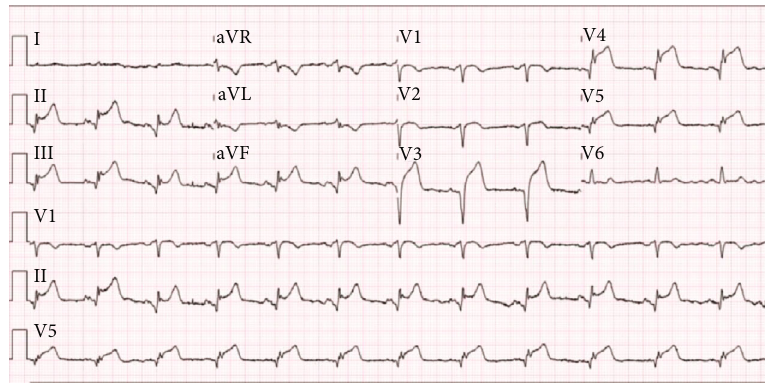
Figure 4: Electrocardiogram exhibiting ST-segment elevations in both the anterolateral and inferior